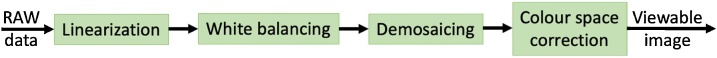
Processing steps for image building from a RAW format image to a viewable CR2 format image.